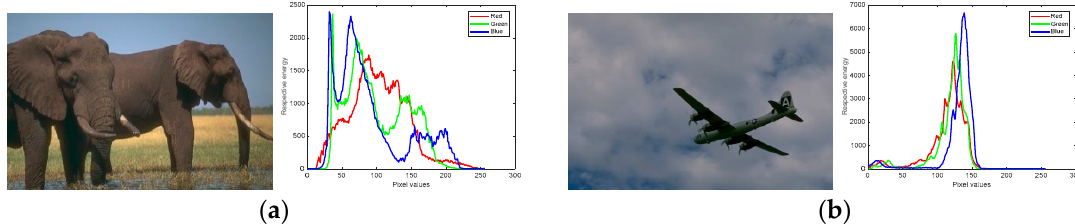
Figure 12. Two natural images from the Berkeley segmentation dataset, which are named ‘Elephant’, and ‘Plane’, respectively, and the corresponding histograms for each of the color channels (red, green, and blue). ( a ) Elephant (481 × 321), ( b ) Plane (481 × 321).